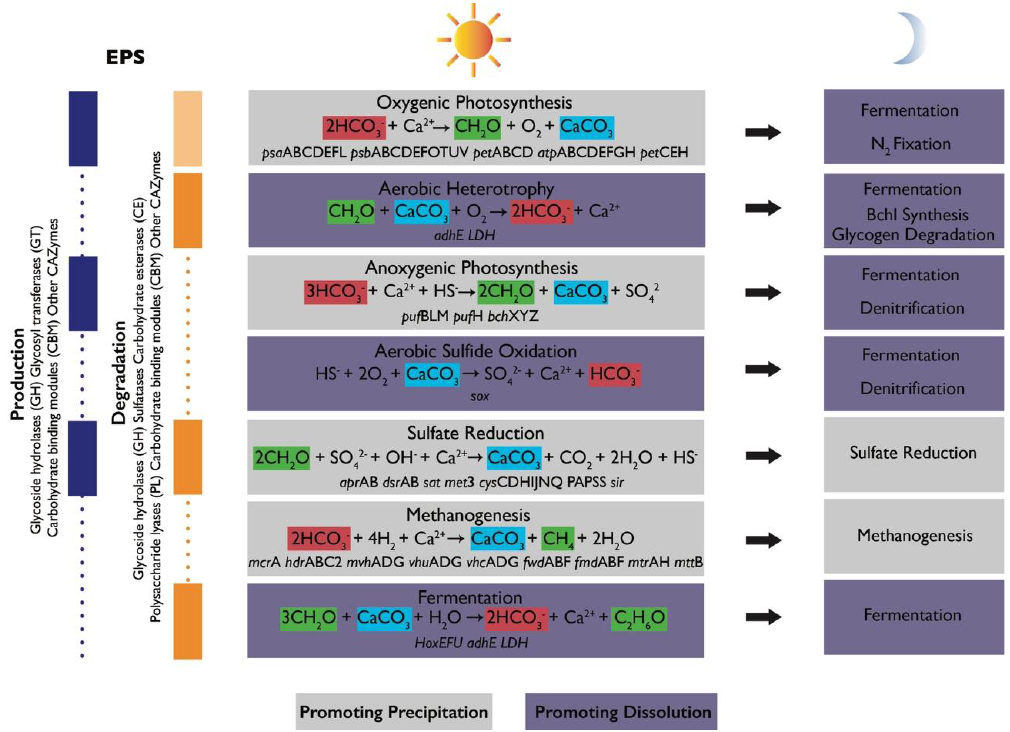
Figure 4. Schematic of metabolic guilds commonly present in microbial mat communities and their contributions to the alkalinity engine (adapted from Reference [4]). Each group includes a simplified equation representing its major metabolism as it relates to the precipitation of carbonate minerals, alkalinity, and the production or degradation of organic matter [46]. Relevant functional genes as- sociated with some of these metabolisms were detected in Shark Bay mats [47 – 50]. Some metabo- lisms promote carbonate precipitation (gray boxes) or dissolution (purple boxes). Shifts in metabolic activity from day to night can alter the net effects of metabolisms. Left column shows the contribu- tion of each group to EPS cycling and lists some gene families associated with production (blue) and degradation (orange). Light orange box corresponding to oxygenic photosynthesis indicates that oxygenic phototrophs (Cyanobacteria) are known to recycle some of their own EPS but are generally considered net producers of EPS. Vertical purple and orange boxes shown known contributions of some microbial groups to EPS cycling. Dotted lines show that there is still much to learn about EPS cycling in mats and the contribution of various groups of organisms. Phototrophic CO 2 fixation favors the net precipitation of carbonate minerals. Oxy- genic photosynthesis takes in HCO 3 - and releases OH - ions to increase carbonate alkalinity and pH. Anoxygenic photosynthetic oxidation of HS - decreases alkalinity; however, sim- ultaneous increases in pH maintain favorable conditions for precipitation. These pro- cesses are restricted to the upper illuminated parts of the mat and are offset by aerobic respiration, which favors carbonate dissolution by increasing pCO 2 . The effects of oxy- genic photosynthesis and aerobic respiration are balanced in time. At night, oxygenic and anoxygenic phototrophs can ferment, fix N 2 , and contribute to denitrification — all pro- cesses that produce protons and favor dissolution. For these reasons, carbonate minerals in modern microbialites precipitate more extensively in the zones of microbial sulfate re- duction and extensive organic degradation [8,32,51] and typically do not preserve the finely laminated photosynthetic textures, such as those shown in Figure 1. The activity of sulfate-reducing bacteria (SRB) is less constrained in time and space. The diversity of or- ganic substrates, the completeness of substrate oxidation, environmental buffering,